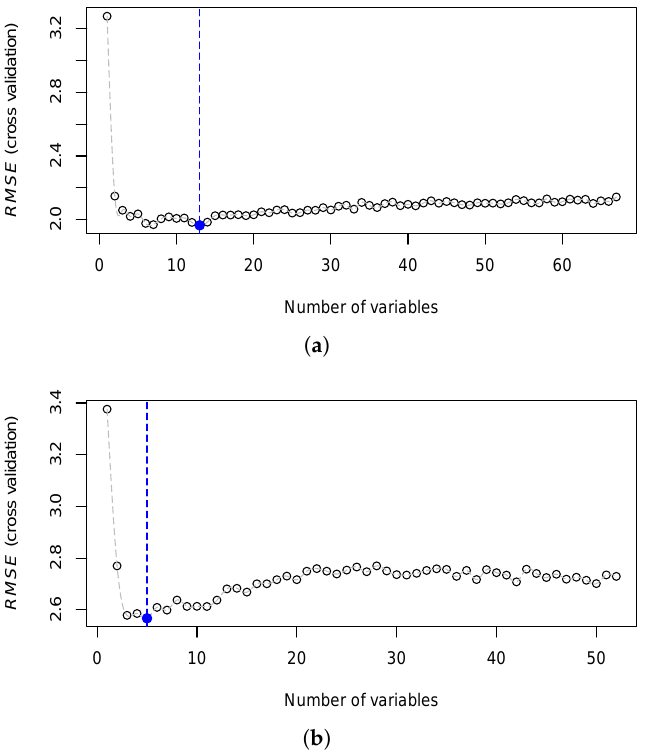
Figure 11. RFE-based dependencies between RMSE values and parameter combinations for scale level L = 0.6 and parametrization variant terrain attributes + SCMaP-SRC (TA+SRC) ( a ) as well as scale level L = 6 and parametrization variant terrain attributes (TA) (( b ); Table 4). The dashed blue lines indicate minimal RMSE